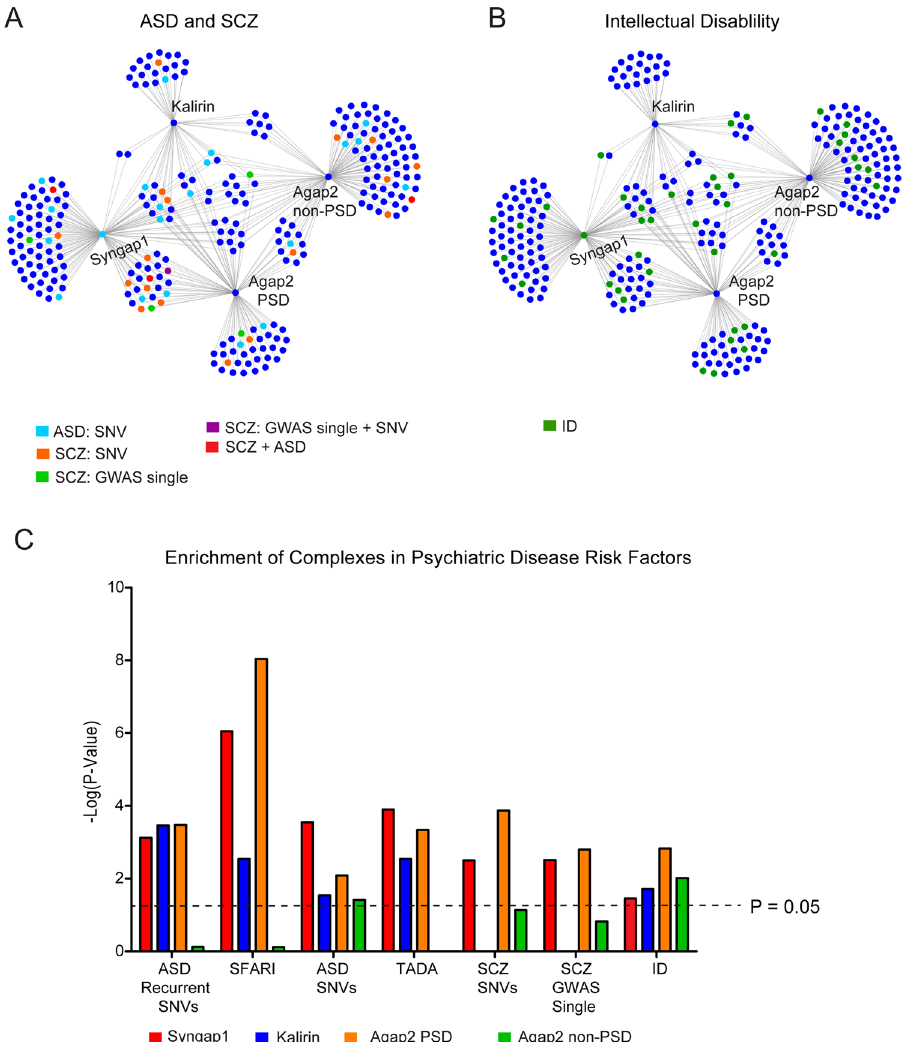
Figure 5. Distribution of Risk Factors for Psychiatric Disease within Protein-Protein Interaction Networks. ( A ) Distribution of risk factors implicated in contributing to autism spectrum disorder (ASD) and schizophrenia (SCZ) within the protein-protein interaction network of Syngap1, Kalirin, Agap2 within the PSD fraction, and Agap2 outside of the PSD. ( B ) Distribution of risk factors implicated in contributing to intellectual disability (ID) within the same protein-protein interaction network as in ( A ). ( C ) Enrichment of risk factors implicated in contributing to SCZ, ASD, and ID within Syngap1, Kalirin, Agap2 PSD, and Agap2 non-PSD